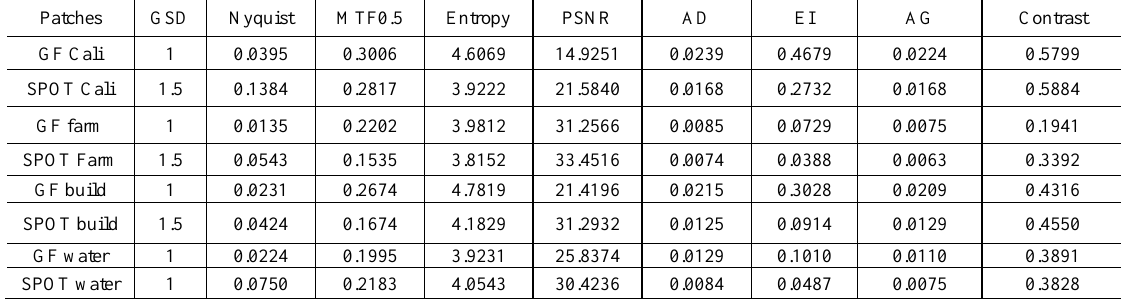
Table 5. The feature vectors of image patches shown